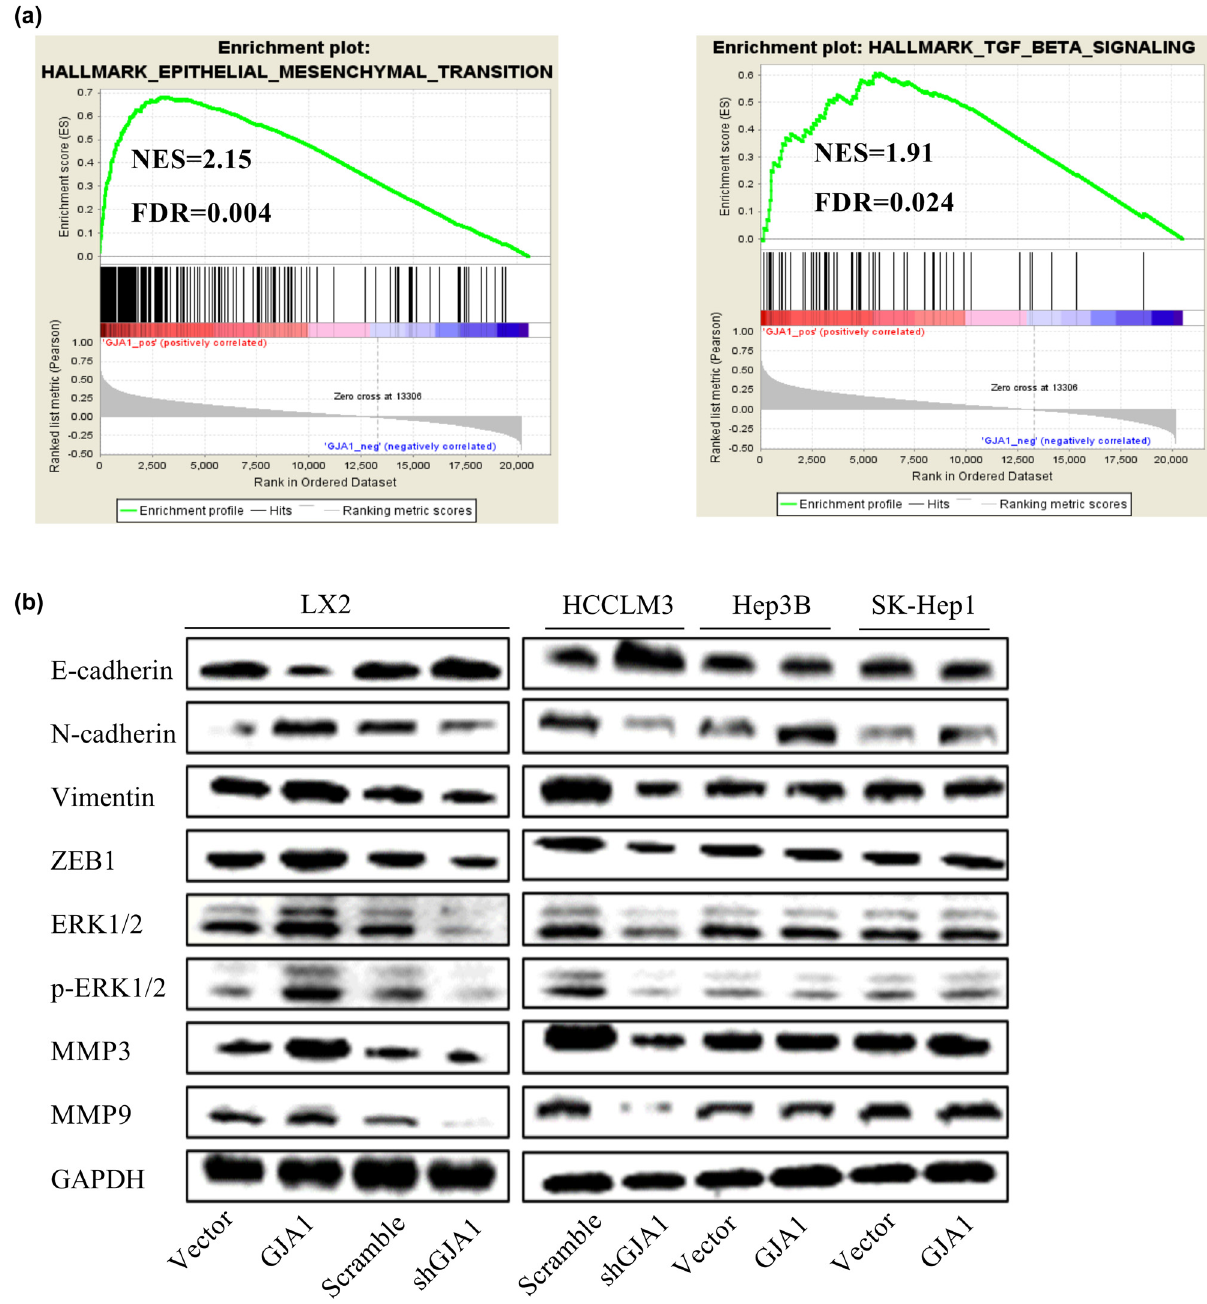
Figure 4: GJA1 induces the EMT. A GSEA indicated that GJA1 expression was positively correlated with the hallmark gene sets EPITHELIAL_MES - ENCHYMAL_TRANSITION ( a, left ) and TGF_BETA_SIGNALING ( a, right ) . Cell lysates were collected from LX2 stable infectants expressing GJA1, vector control, shGJA1, or scrambled control cells, followed by western blot analyses with the indicated antibodies ( b, left panel ) . HEP3B and PLC - PRF - 5 cells were transduced with lentiviruses carrying GJA1 or vector control, while HCCLM3 cells were transduced with shGJA1 or the scrambled control. Cell lysates were collected and were analyzed using western blotting with the indicated antibodies ( b, right panel ) . EMT, epithelial – mesenchymal transition; ERK, extracellular regulated protein kinases; FDR, false discovery rate; GJA1, gap junction protein, alpha 1; GSEA, Gene Set Enrichment Analysis; MMP, matrix metalloproteinase; NES, normalized enrichment score; ZEB1, zinc fi nger E - box - binding homeobox